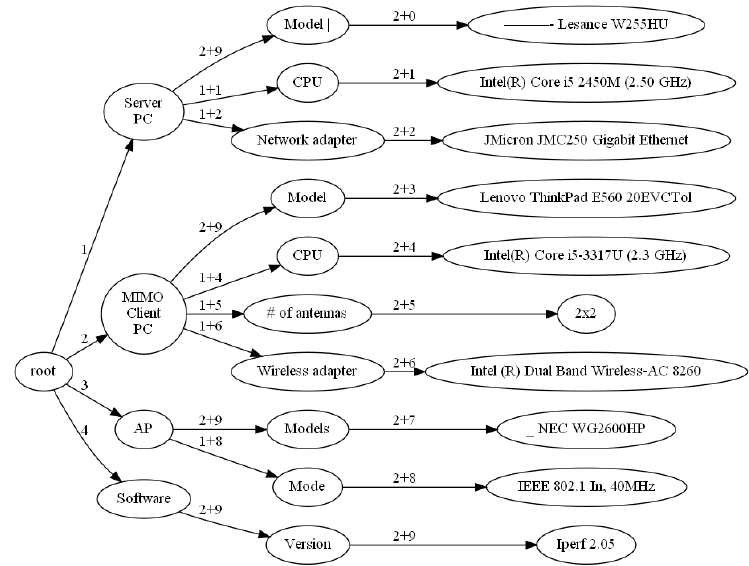
Figure 8. Tree structure of the table.